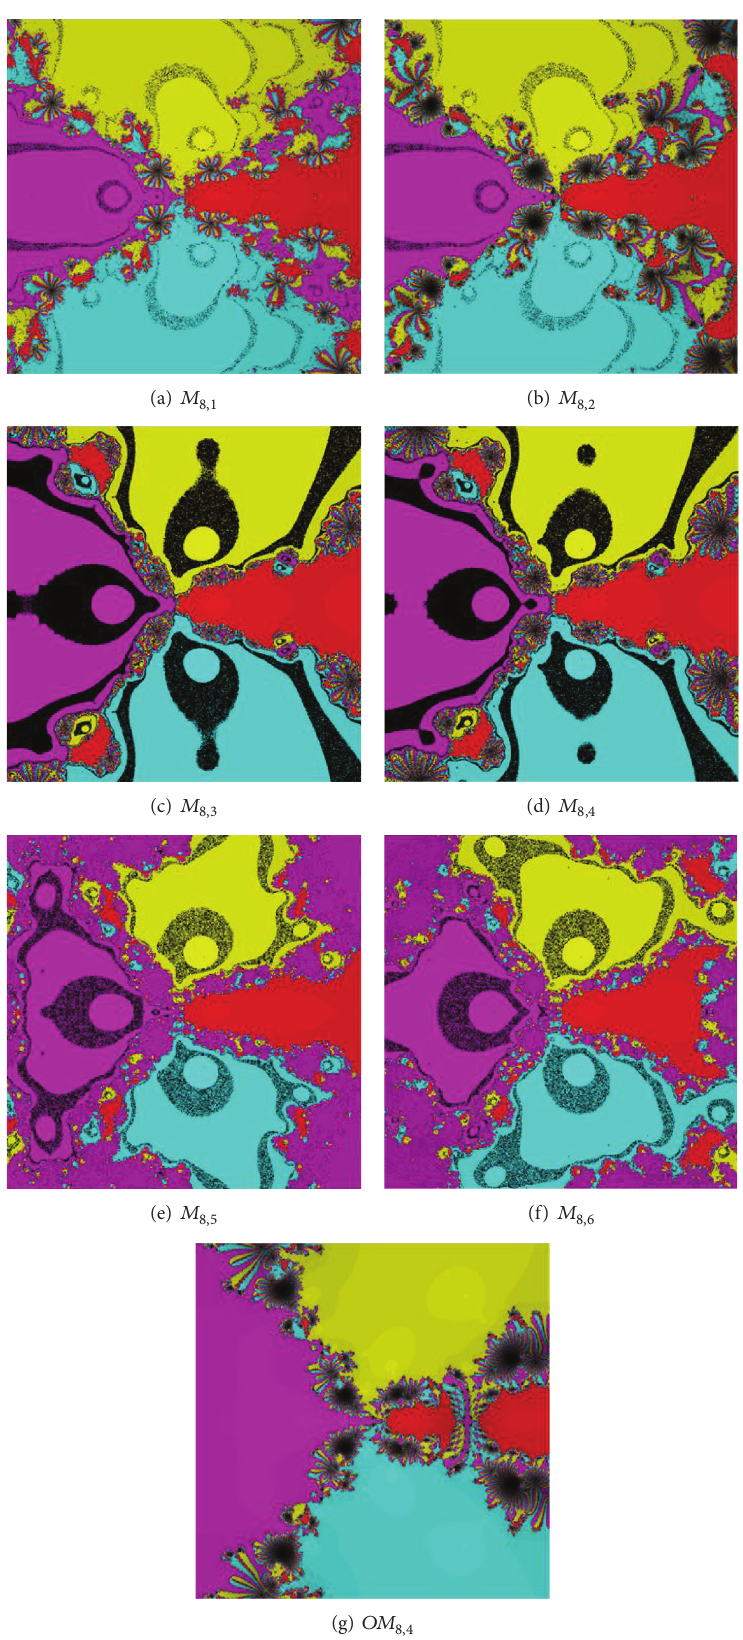
Figure 7: Basins of attraction for nonpolynomial 𝑃 3 (𝑧) = (𝑧 3 − 1/2𝑧 + 1)